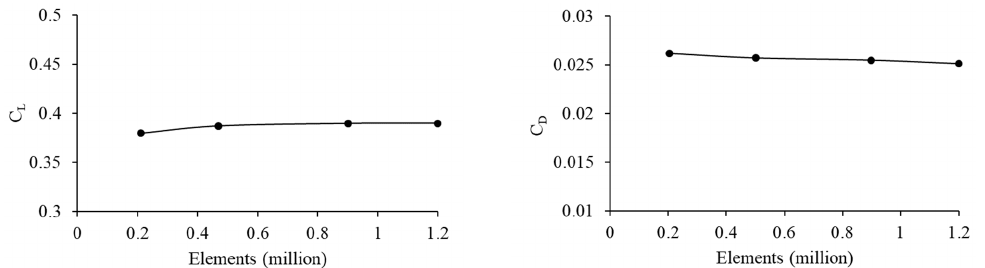
Figure 15. BWA/SL aircraft in cruise flight condition S 3 (M = 0.7 at 43,000 ft) with an angle-of-attack α = 0°. Overall lift ( left ) and drag ( right ) coefficients obtained through a grid convergence study.